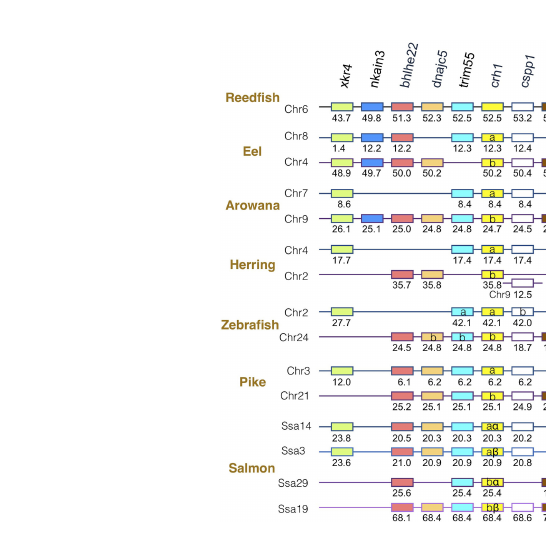
FIGURE 2 | Synteny of crh1 genomic region in actinopterygians. Crh1 gene neighborhood is compared between teleost representatives, eel, arowana, herring, zebra fi sh, pike and salmon. The polypteriform actinopterygian, reed fi sh, was used as model of the gene arrangement prior the teleost genome duplication 3R. Chromosomes are indicated by Chr or Ssa for salmon. Gene position are indicated under the genes. Loss of crh1 gene is indicated with a red cross. Neighboring genes non-represented are considered as lost. Gene references are presented in Table S3 . Letters a and b indicate the 3R-teleost duplicated paralogs and the symbols a and b the 4R-salmonid duplicated paralogs. Members of gene families conserved on the vertebrate tetraparalogon (issued from 1R/2R WGD) are with the same color in Figures 3 – 4